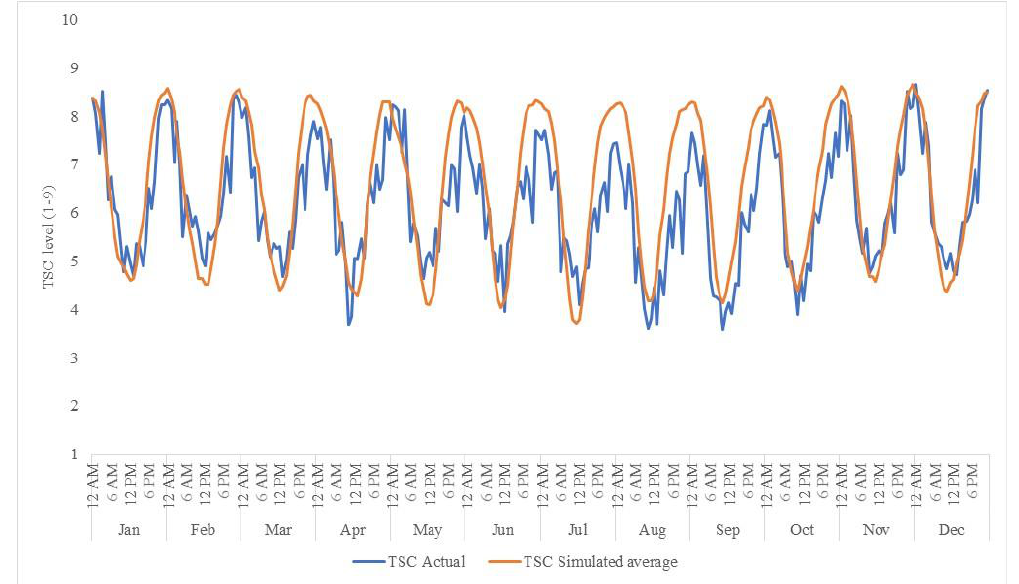
Figure 4. Simulated total sky cover and historical data daily half hour averages by month.